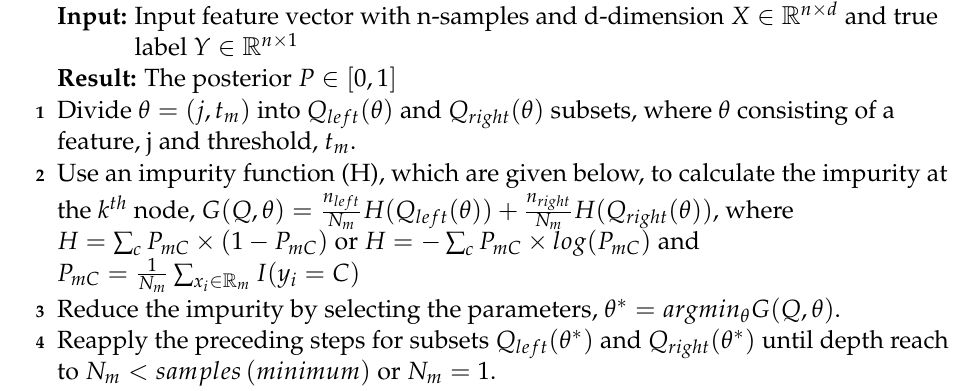
Algorithm 8: The procedure for applying the DT diabetes detection